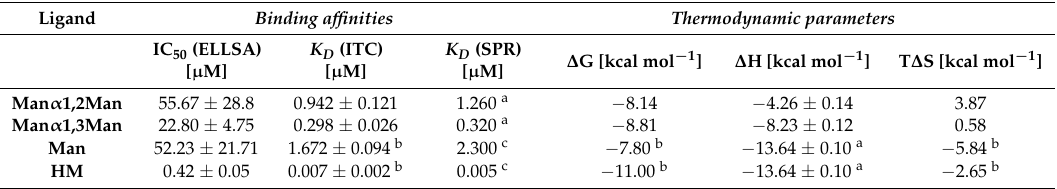
Table 1. Binding affinities and thermodynamic characteristics of the binding of different mono- and dimannoses to FimH. The data used to determine the IC 50 values and the thermodynamic parameters are shown in Figures 1 and 2, respectively.